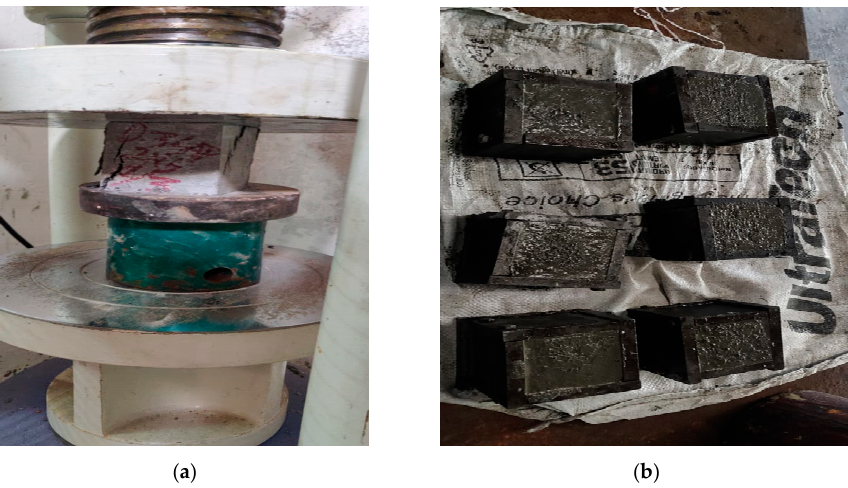
Figure 5. ( a ) Test setup of compressive test; ( b ) preparation of blended mix samples.